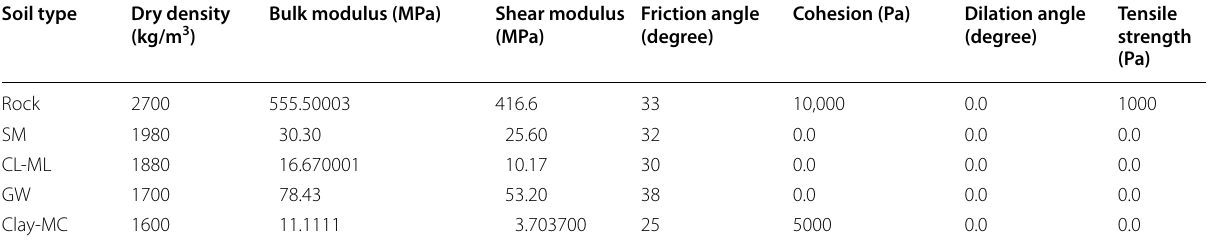
Table 8 The characteristics of the different soil types. Soil